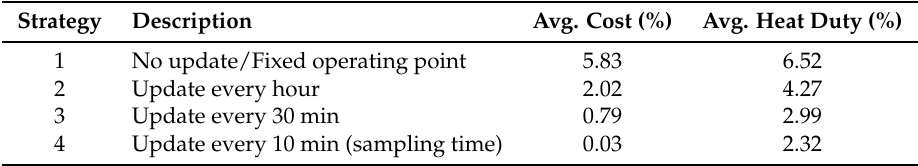
Table 3. Different MPC set-point update strategies and percent decrease in economics and heat duty.